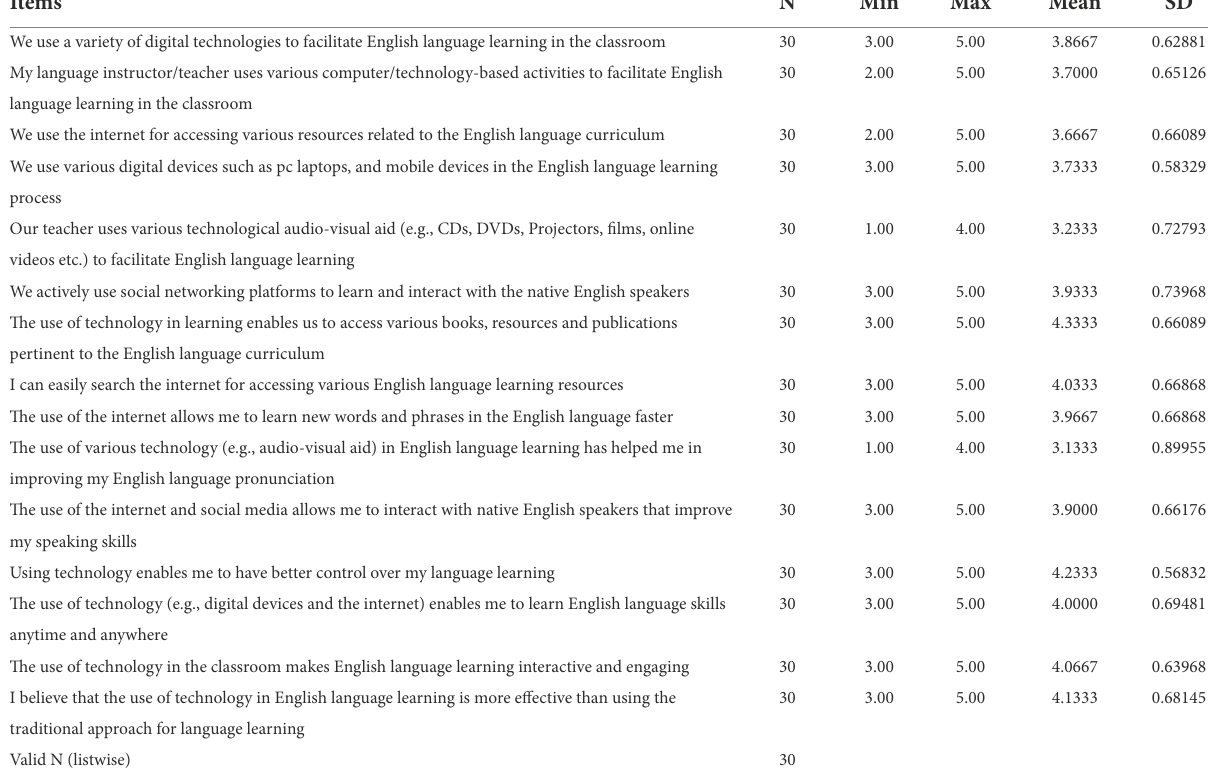
TABLE 4 Survey results of Egyptian linguistic